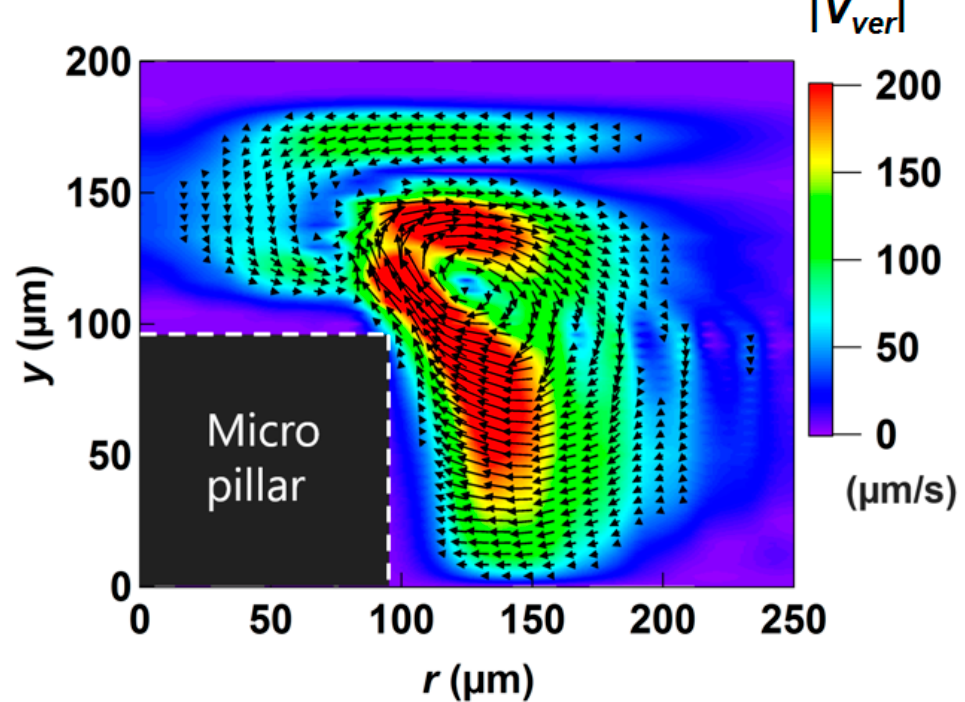
Figure 12. Vector plot of the averaged velocity flow (Lagrangian method) in the vertical plane.